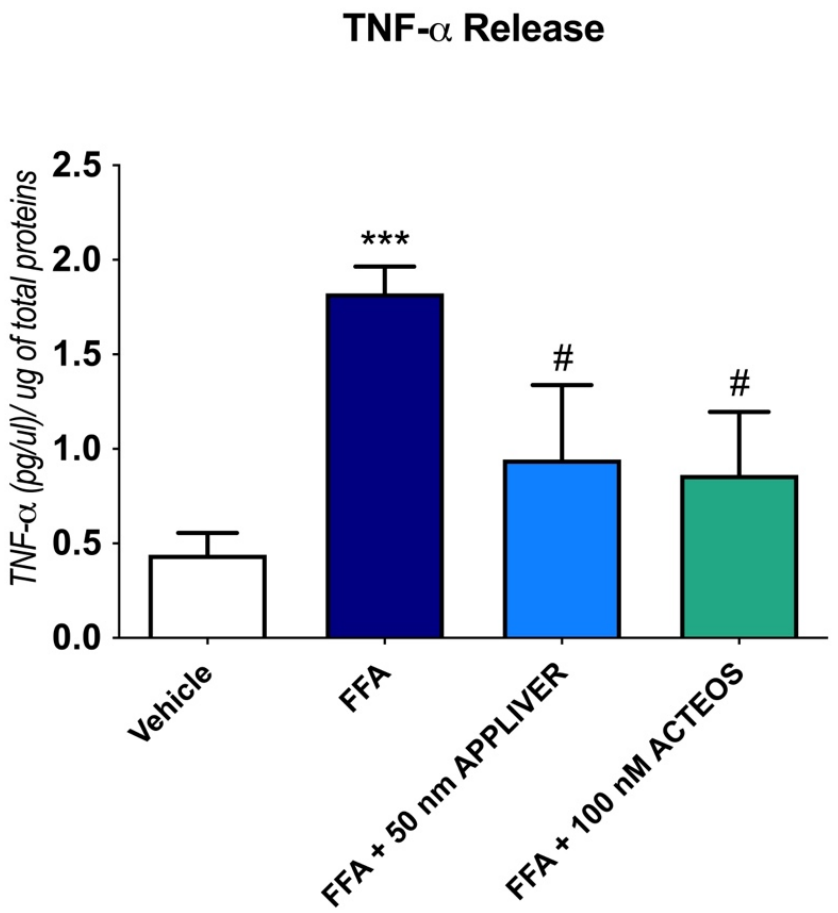
Figure 4. Quantification of TNF- α release in cell culture supernatant ((pg/ µ L)/ µ g of total proteins) upon treatment with either APPLIVER (A) or ACTEOS (B) ± FFA after 1 h. Values presented are the mean ± SD of three independent experiments. *** p < 0.001 vs. vehicle, # p < 0.05 vs. FFA. Abbreviations: FFA, free fatty acids; TNF- α , tumor necrosis—alpha.